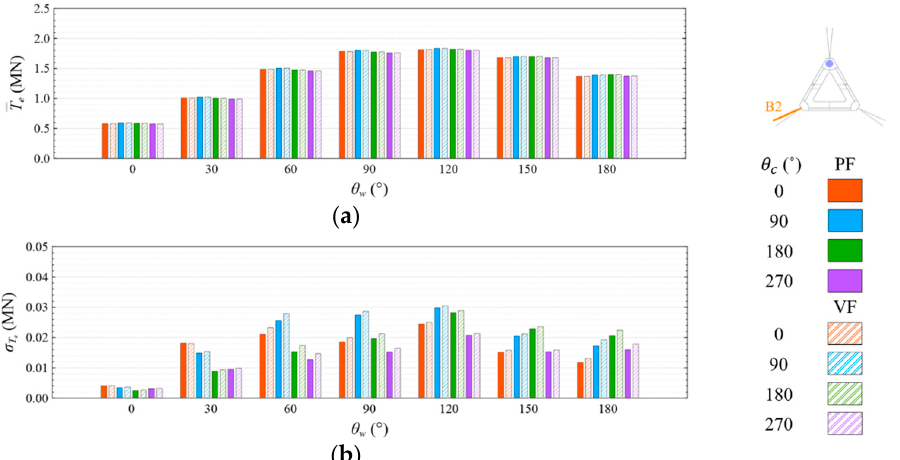
Figure 31. Comparison of ( a ) means and ( b ) standard deviations of mooring line tension of Line B2 under CW condition.